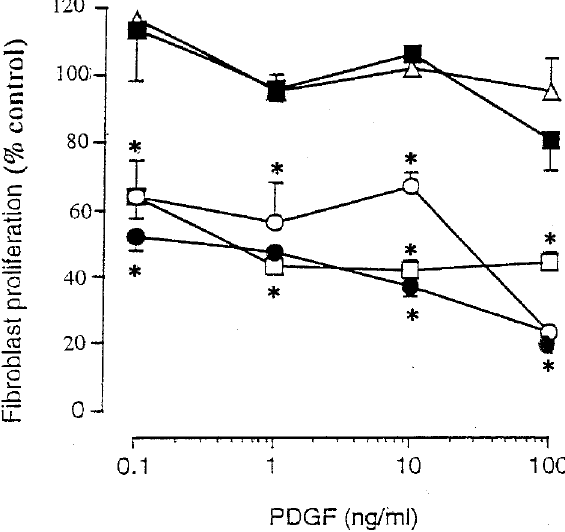
FIG. 2. The effect of heparin (10U/ml, open circles; 100U/ml, closed circles), heparan sulphate (100 m g/ml, closed squares), de-N-sulphated heparin (100 m g/ml, open squares) and poly- L -gultamic acid (100 m g/ml, open triangles) on lung fibroblast cell division induced by PDGF (0.1–100ng/ml). Each point represents the mean ands.e.mean derived from one of three experiments conducted with four replicates for each mean. p < 0.05 compared with the value for PDGF treatment